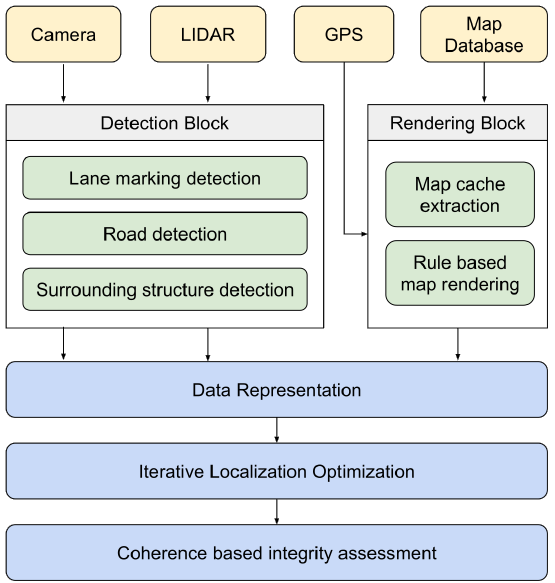
Figure 2. Framework for integrity assessment of multimodal data